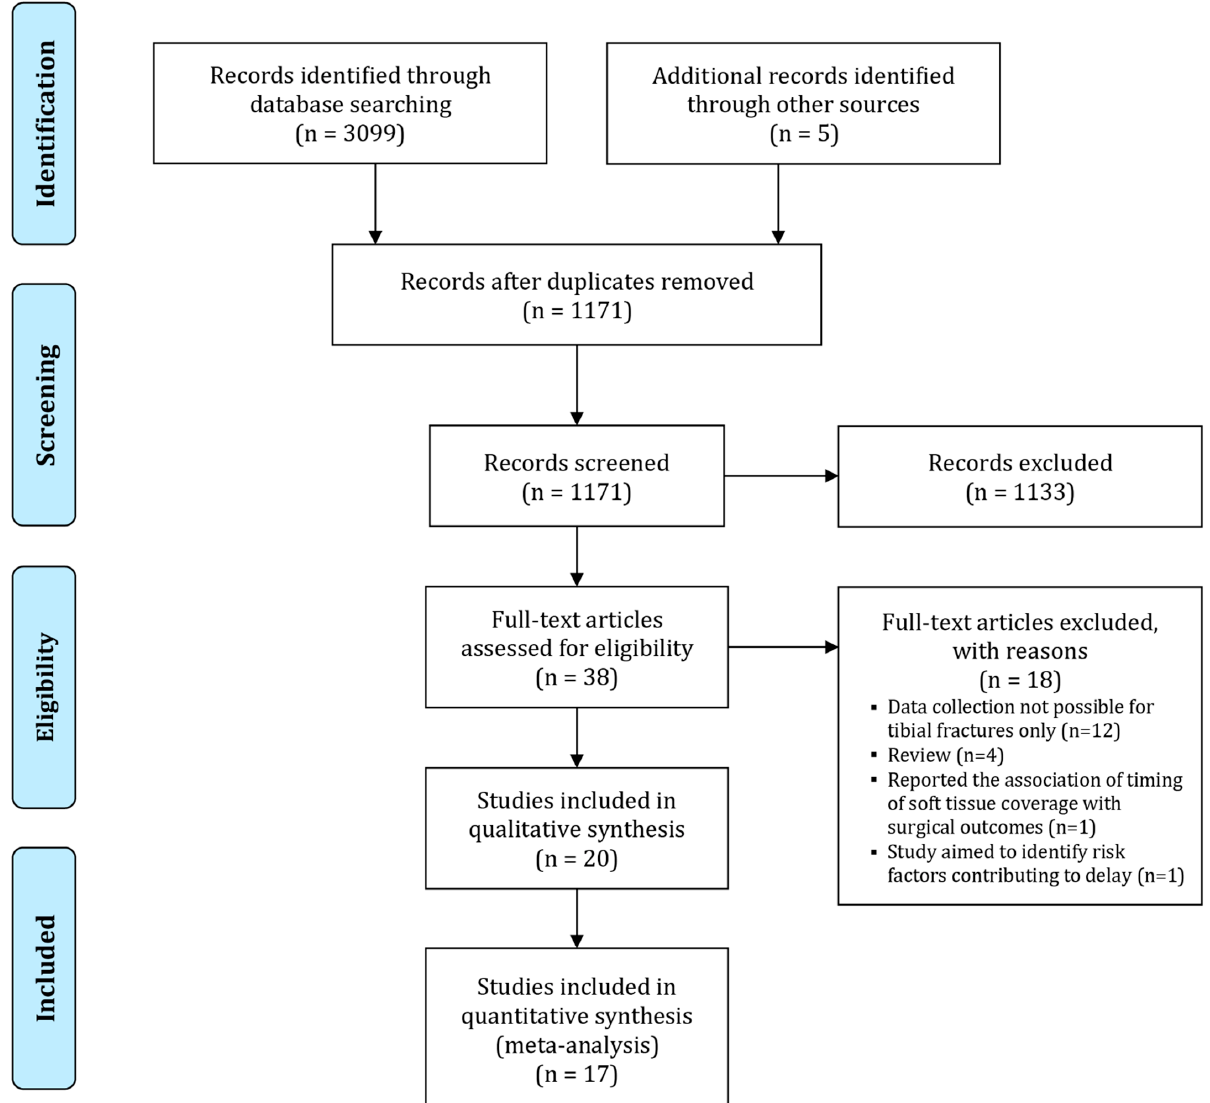
Figure 1. PRISMA flow diagram of study selection.